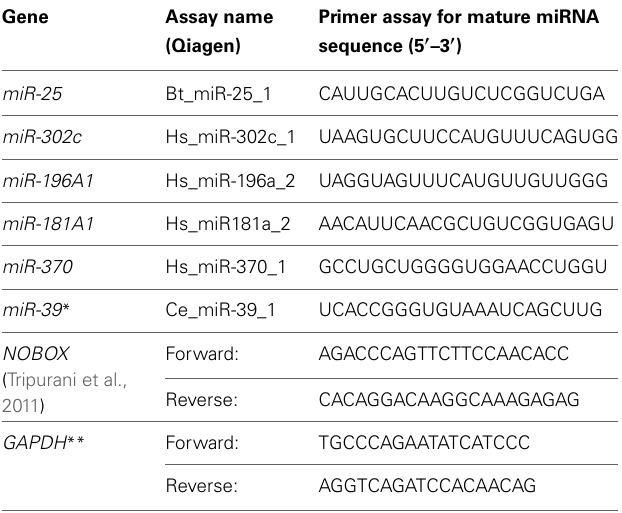
Table 2 | qRT-PCR primer sequences.